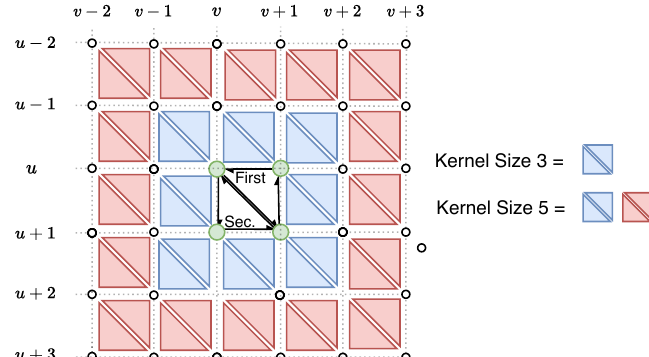
Figure 8. Visualization of a triangle’s neighborhood during bilateral filtering of an organized point cloud. Each 2 × 2 point group forms two triangles creating a mesh. Each triangle’s neighbors are defined by the kernel size. For example a kernel size of five includes all blue and red triangles.